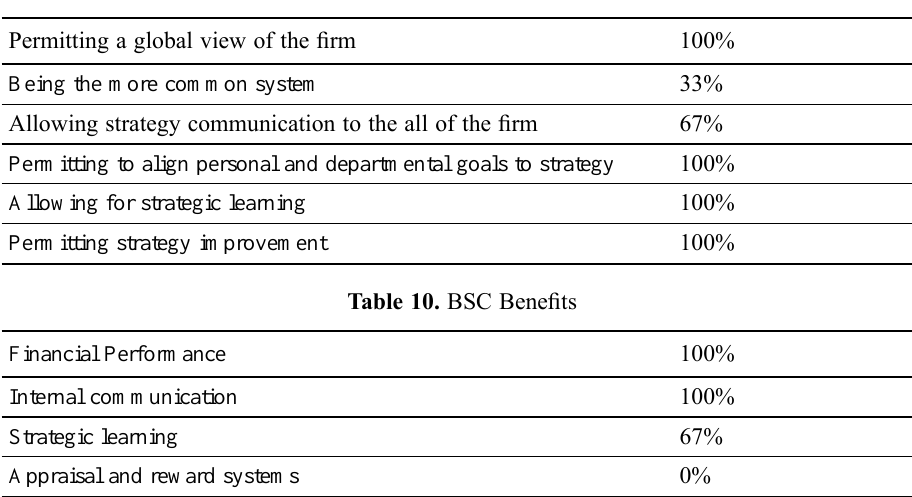
Table 9. Justification for BSC use